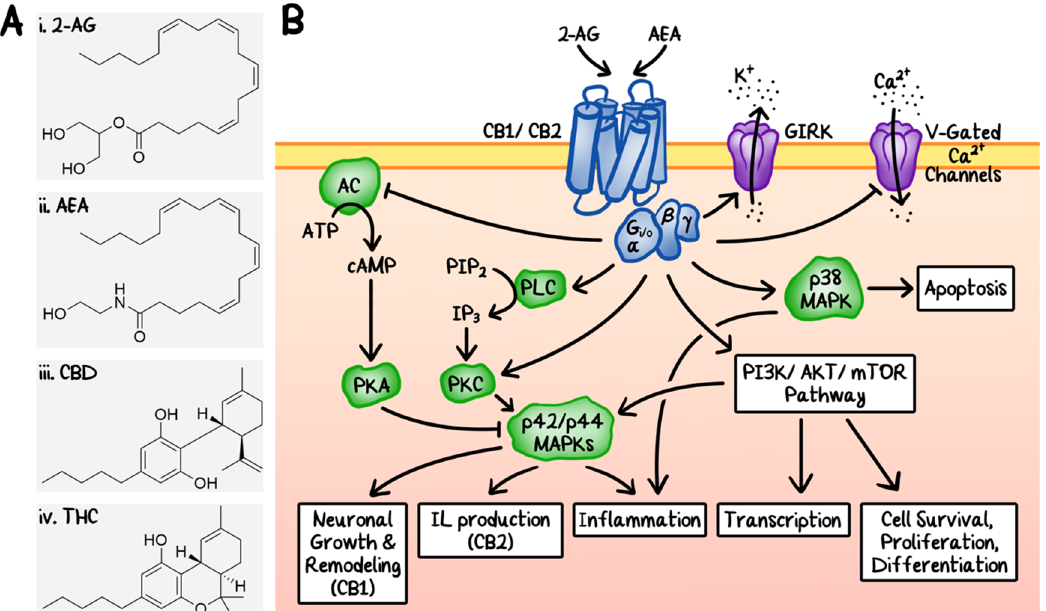
Figure 1. Endocannabinoid system. ( A ) Chemical structures of two endogenous cannabinoids, 2-arachidonylglycerol ( i , 2-AG) and N -arachidonylethanolamine ( ii , AEA), and two representative exogenous cannabinoids from Cannabis sativa , cannabidiol ( iii , CBD) and Δ 9 -tetrahydrocannabinol ( iv , Δ 9 -THC). ( B ) Schematic diagrams of the signaling transduction pathways of the endocannabinoid system. 2-AG and AEA are agonists of CB 1 and CB 2 . Some of the downstream effects include: (1) upregulation of p42/p44 mitogen-activated protein kinases (MAPKs) by direct inhibition of adenylyl cyclase (AC) and direct activation of phospholipase C (PLC), leading to the induction of neuronal growth, interleukin production, and inflammation. PKA: protein kinase A. PKC: protein kinase C. (2) Activation of p38 MAPK, which induces inflammation and apoptosis. (3) Activation of the phosphatidylinositol-3-kinase (PI3K)/AKT and the mammalian target of rapamycin (mTOR) signaling pathways. Under certain conditions, these endocannabinoids can also induce transcription, cell survival, proliferation, and differentiation through similar pathways. Additionally, the cannabinoid receptors can also modulate ion channels including G protein-coupled inwardly-rectifying potassium channels (GIRKs) and voltage (V)-gated calcium channels.